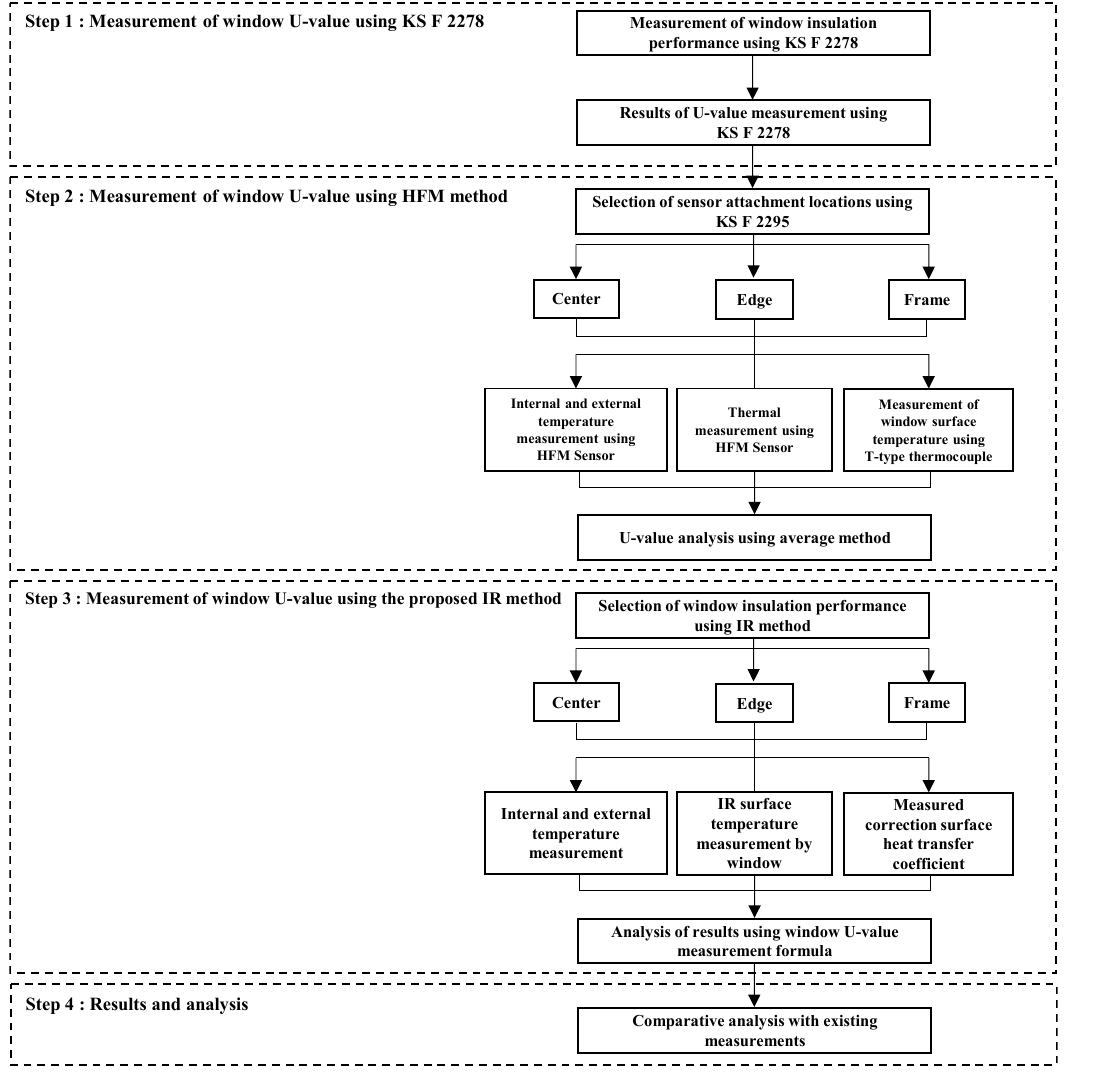
Figure 1. Overall study process.